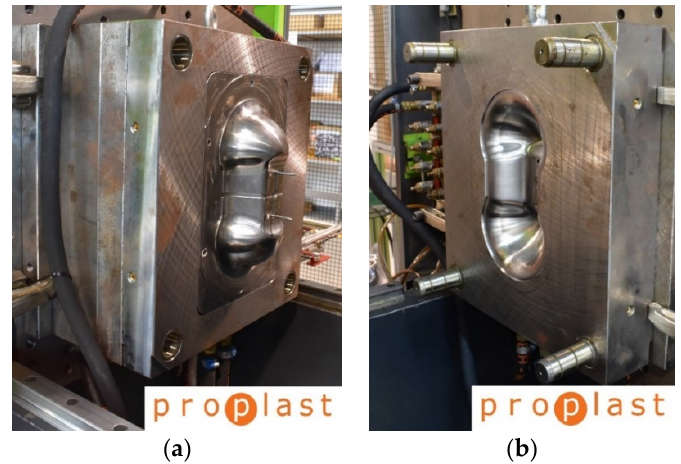
Figure 8. The mold punch ( a ) and the mold die ( b ).